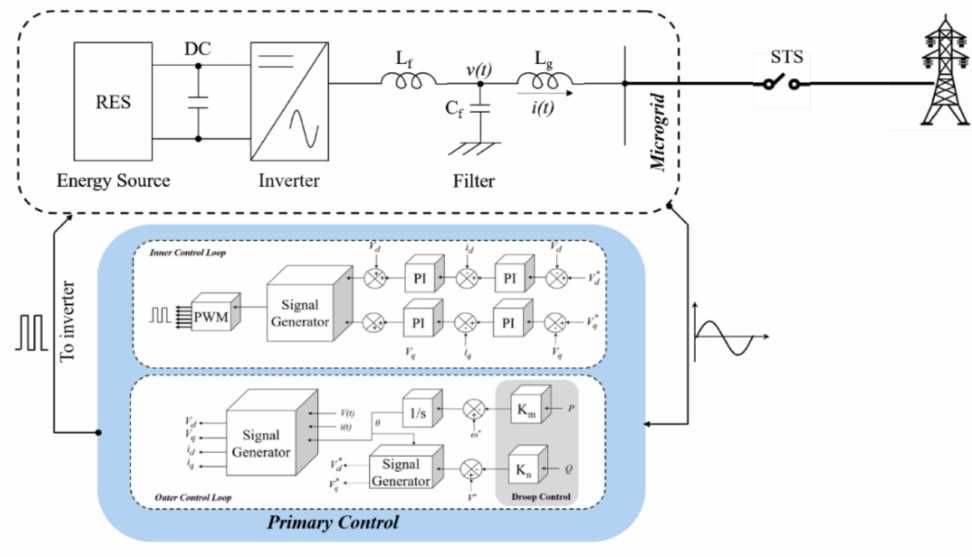
Figure 3. Primary control structure’s block